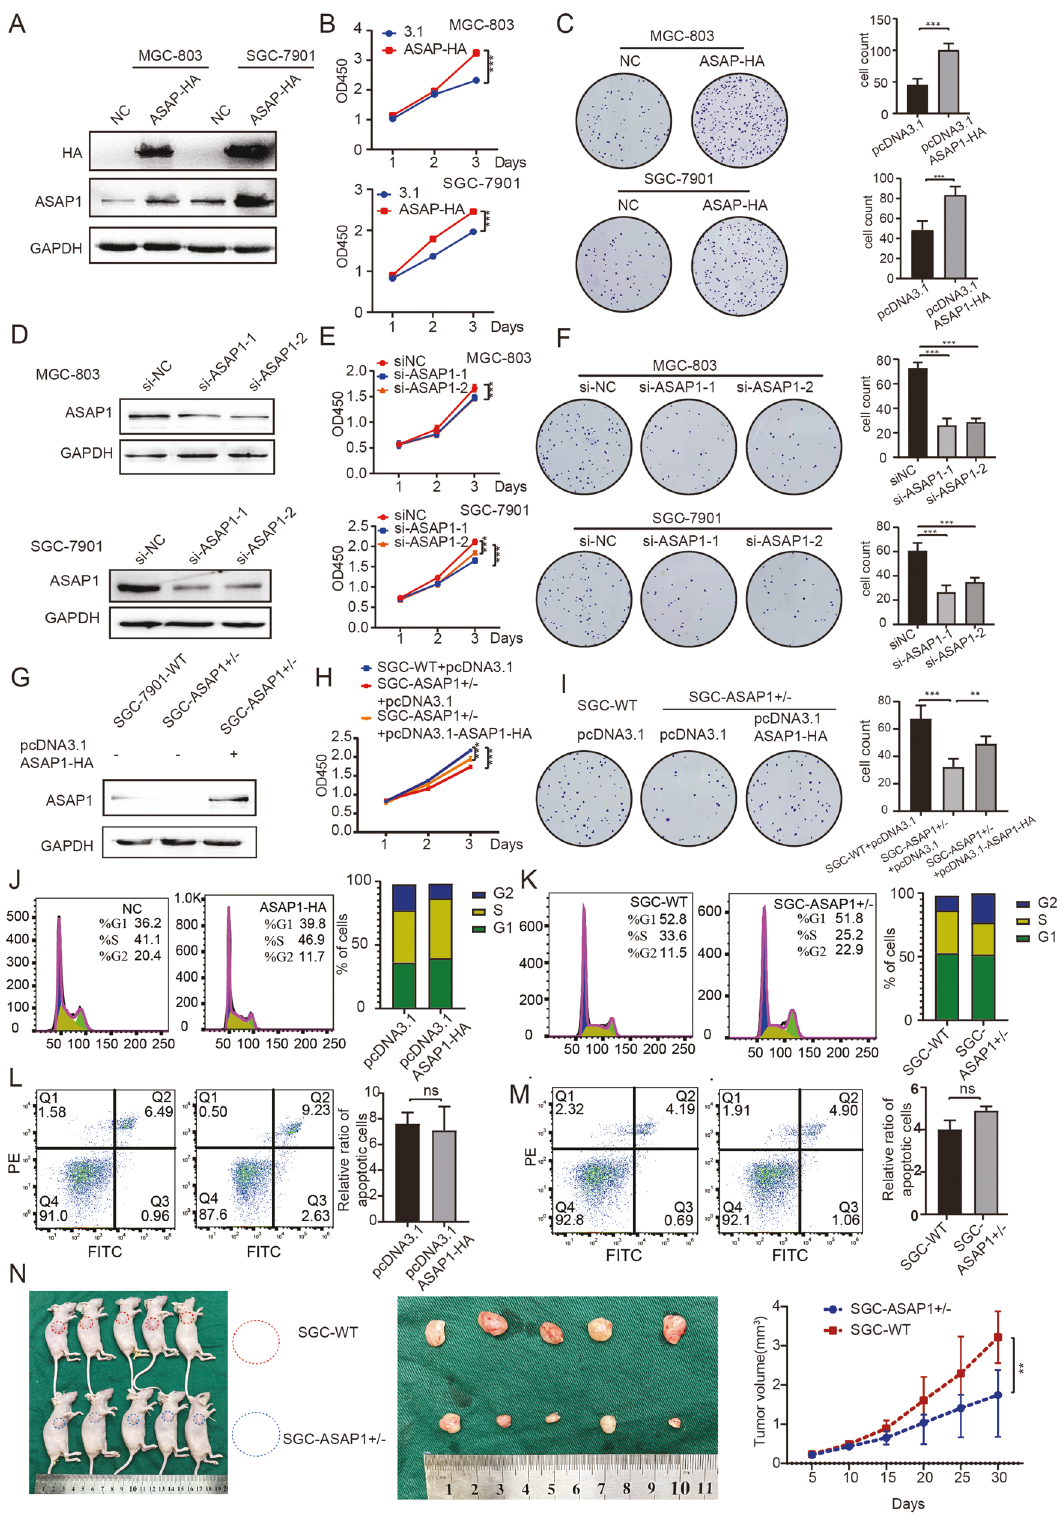
Fig. 3 ASAP1 promotes GC cell proliferation in vitro and xenograft tumor growth in vivo. A , D , G Western blot analysis of ASAP1 of MGC- 803 and SGC-7901 cells expressing ASAP1-HA, depleted of ASAP1 by siRNA or partially knocked out of ASAP1 by CRISPR-Cas9. B , E , H CCK-8 assays with MGC-803 and SGC-7901 cells expressing ASAP1-HA, depleted of ASAP1 by siRNA or partially knocked out of ASAP1 by CRISPR- Cas9. C , F , I Representative images from colony formation with MGC-803 and SGC-7901 cells expressing ASAP1-HA, depleted of ASAP1 or partially knocked out of ASAP1. J , K Cell cycle assay of SGC-7901 cells expressing ASAP1-HA or partially knocked out of ASAP1. L , M Apoptosis assay of SGC-7901 cells expressing ASAP1-HA or partially knocked out of ASAP1. N In vivo analysis using a tumor xenograft model. The growth curve of xenograft tumors from WT ( n = 5) and ASAP1 ± ( n = 5) SGC-7901 cells. ns not signi fi cant; * p < 0.05; ** p < 0.01; *** p < 0.001.